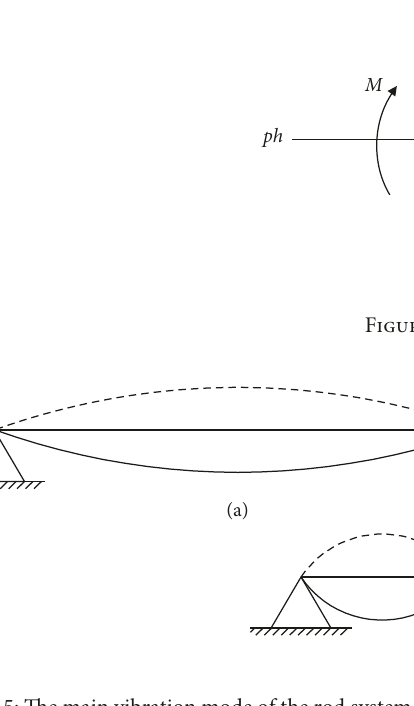
Figure 15: The main vibration mode of the rod system. (a) The first vibration mode. (b) The second vibration mode. (c) The third vibration mode.